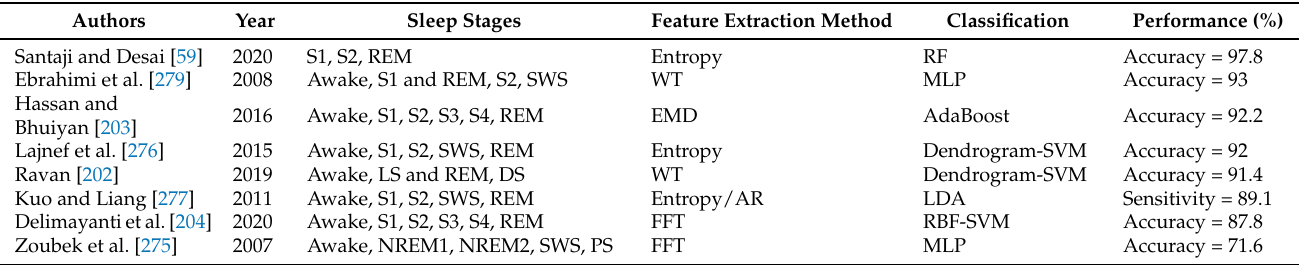
Table 6. Comparison of studies for the sleep stage scoring task, including sleep stages, feature extraction method, machine learning algorithm, and overall